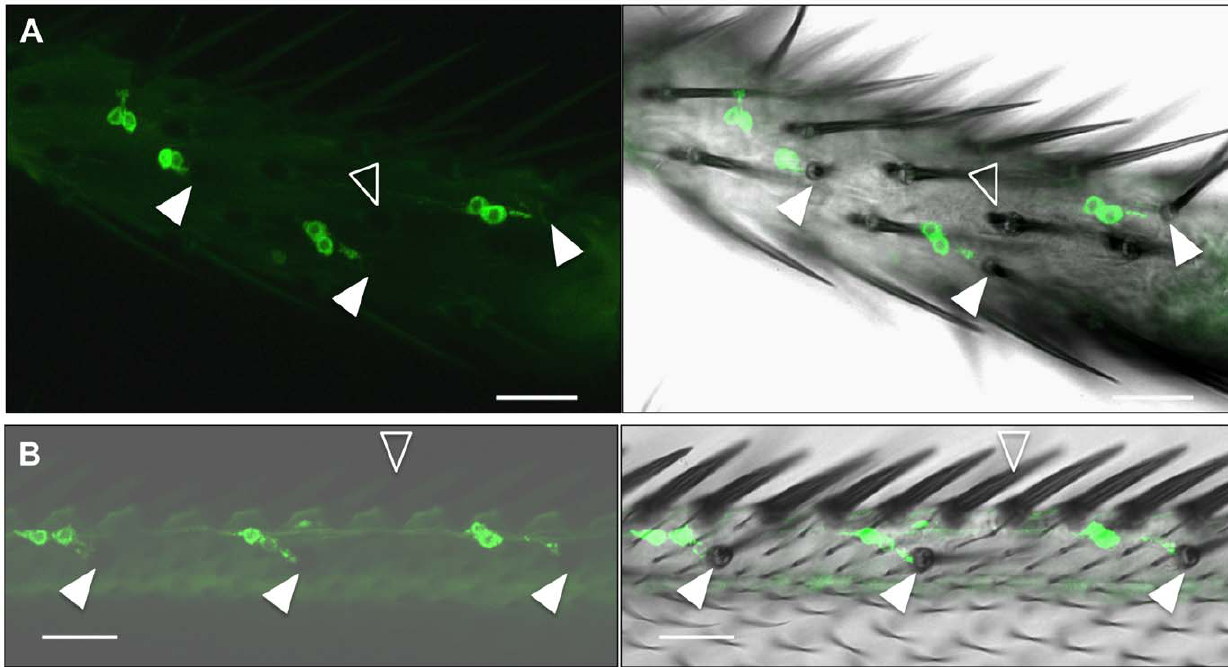
Figure 2. ppk23 is expressed in adult chemosensory receptor neurons. (A) ppk23-GAL4 x UAS-CD8::GFP flies show expression in chemosensory neurons in male forelegs. Left panel is a z-stack of confocal GFP images. Right panel is a merge of the left panel with differential interference contrast (DIC) image. Solid arrows point to the base of bract-less chemosensory bristles. Note the sensory cilia projecting to the base of the bristle. Open arrowhead points to a bract associated with a mechanosensory bristle. Scale bar represent 20 m m. (B) ppk23-GAL4 x UAS-CD8::GFP flies show expression in sensory neurons projecting to chemosensory bristles in wings. Images are as in (A) and were obtained from the same animal. Solid arrowheads point to the base of chemosensory bristles. The open arrowhead points to the line of pure mechanosensory bristles found at the most outer rim of the wing. Scale bar represents 20 m m.